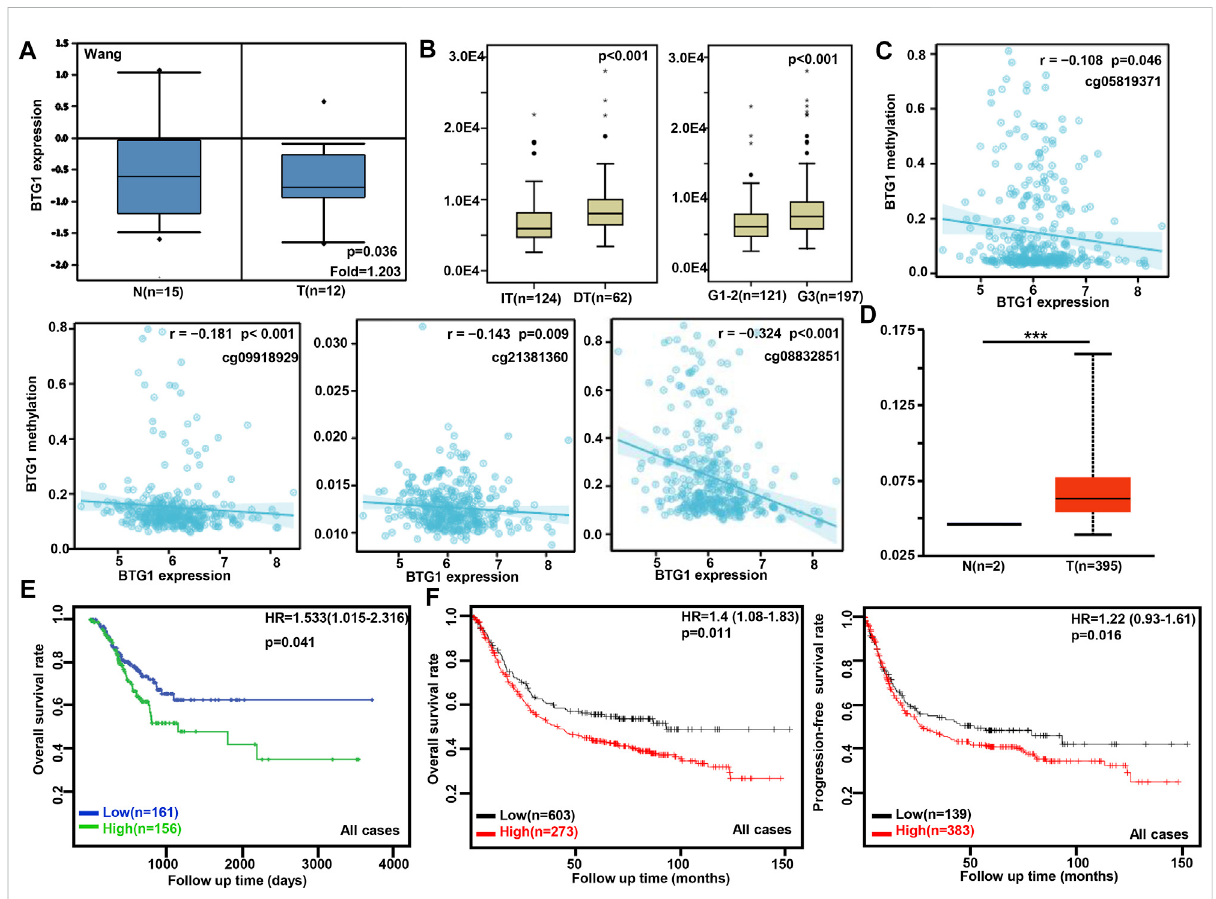
FIGURE 1 The clinicopathological and prognostic signi fi cances of BTG1 mRNA expression in gastric cancer. Wang ’ s (A) dataset was used for bioinformatics analysis to explore BTG1 expression in gastric cancer. A lower BTG1 expression was detectable in gastric cancer than that in normal mucosa( p < 0.05).TCGAdatabaseshowed that BTG1 wasnegativelycorrelated withLauren ’ sclassi fi cationand histological staging ofgastriccancer (B) p < 0.05. The negative relationship between BTG1 expression and methylation was analyzed in gastric cancer using xiantao database (C) . Its methylation was higher in gastric cancer than normal tissues in UALCAN (D) . BTG1 expression was negatively correlated with overall survival rate of the cancer patients by TCGA (E) p < 0.05. It was the same for the overall and progression-free survival rates of the patients with gastric cancer according to the data from Kaplan-Meier plotter (F) p < 0.05. Note: N, normal tissue; T, tumor; HR, hazard ratio; IT, intestinal-type; DT,